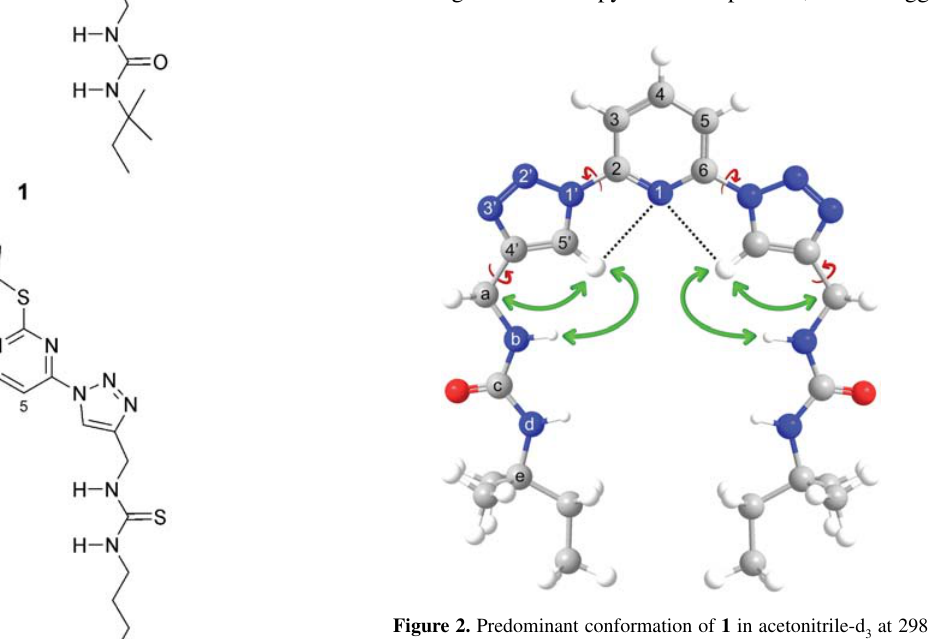
Figure 2. Predominant conformation of 1 in acetonitrile-d K based on NOESY cross-peaks; the key NOESY correlations are marked with green arrows. Red arrows indicate four main single bonds, which are expected to define the binding affinity of the re-